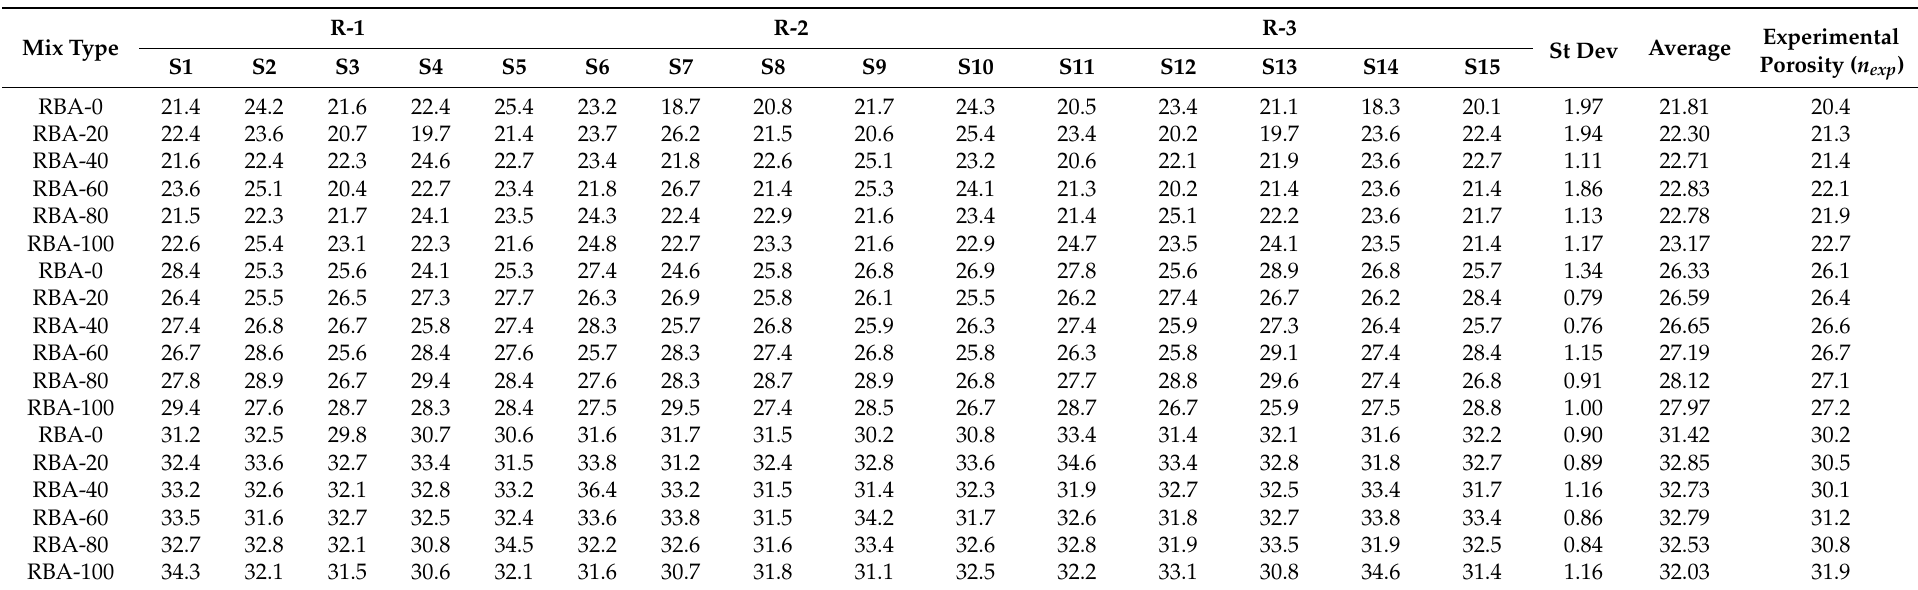
Table 4. Details of area fractions obtained from